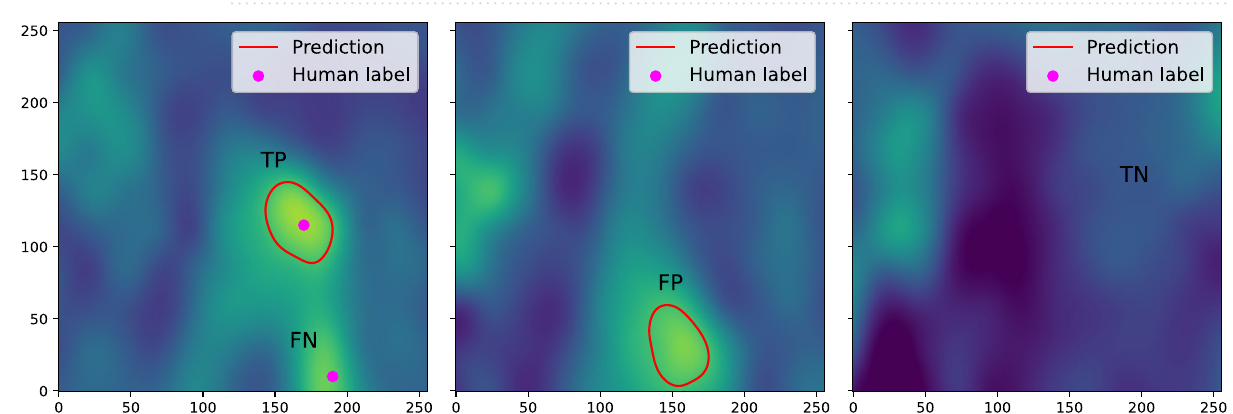
Figure 4. Examples of model prediction on the real data with human labels. The labeler marks a dot (magenta) on the blob that he/she identifies in every frame. As illustrated in the left figure, TP is true positive where the human-labeled dot is contained inside the predicted blob boundary, and FN is false negative where the human- labeled dot is not contained in any predicted blob boundary. FP is a false positive (middle figure) where the predicted blob boundary does not contain human labels. In the right figure, there are neither predictions nor human labels in this frame, hence the case of true